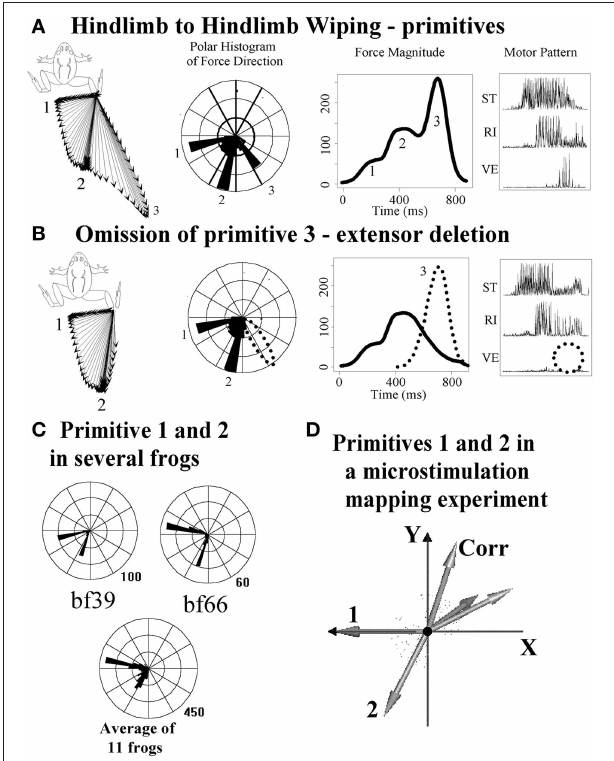
FIGURE 2 | Correspondence of ISMS force direction clusters to primitives recruited and deleted from natural behaviors. Data re-plotted from Giszter and Kargo (2000). (A) Hindlimb wiping with the limb held isometrically results in three generation of force directions (vector plot and polar histogram) and three overlapping force pulses (magnitude plot) with associated EMG. (B) Omission (i.e., deletion as per Stein) of phase 3 and phase 2 can occur. Here phase 3 is lost. The effect is to remove a force pulse in a specific direction and an EMG synergy from the wiping pattern. (C) These effects are consistent across frogs, as seen in polar histograms. (D) The polar histograms in (C) correspond to directions elicited by ISMS (e.g., in the maps in Figure 1 , panel 1). Primitive 1 and 2 in (D) , from ISMS, correspond to the polar histogram directions in several frogs in (C) , suggesting that natural primitives/modules are recruited by ISMS. Corresponding with the deletions of synergies/primitives shown here, there are also added-in corrections (Kargo and Giszter, 2000) showing superposition of synergies/primitives is a general method of spinal motor pattern